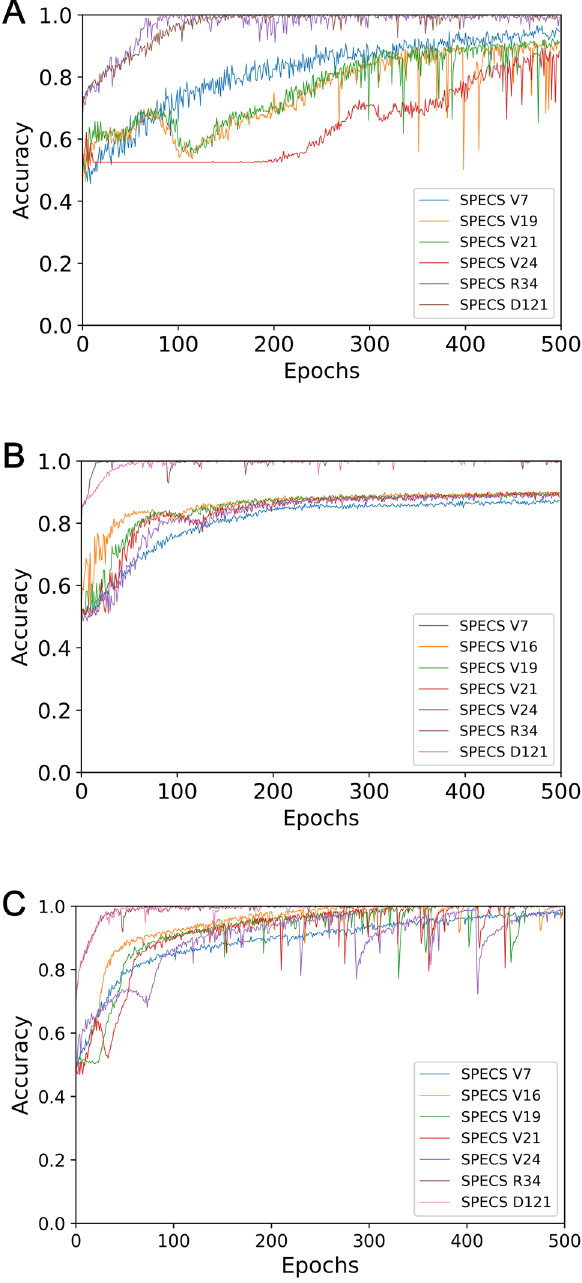
Figure 8. The accuracy curves obtained by training classifiers on training subsets in different datasets. ( a ) Dataset D 1 ; ( b ) Dataset D 2 ; and ( c ) Dataset D 3